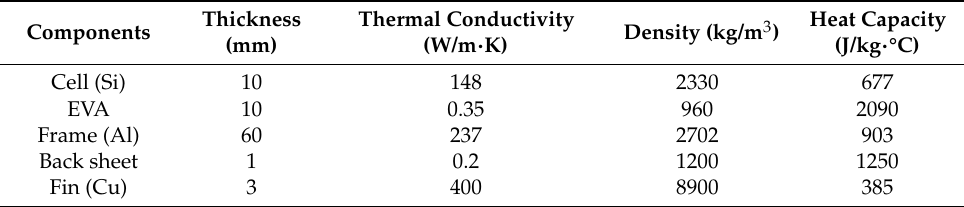
Table 4. Thermal properties.